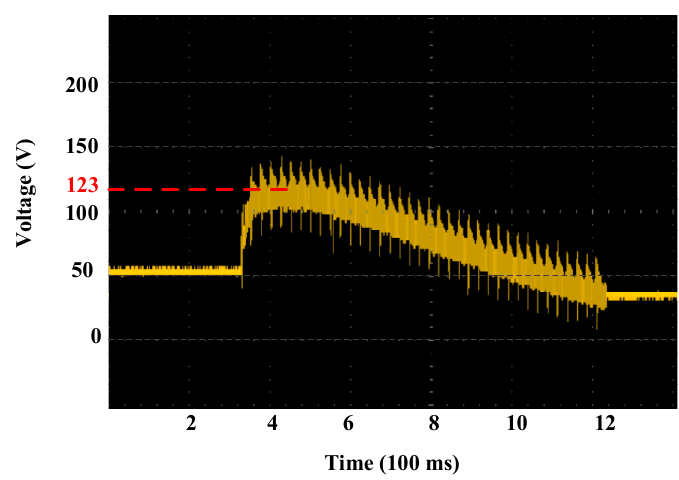
Figure 11. Boosted voltage when the battery is in series with the pump capacitor.